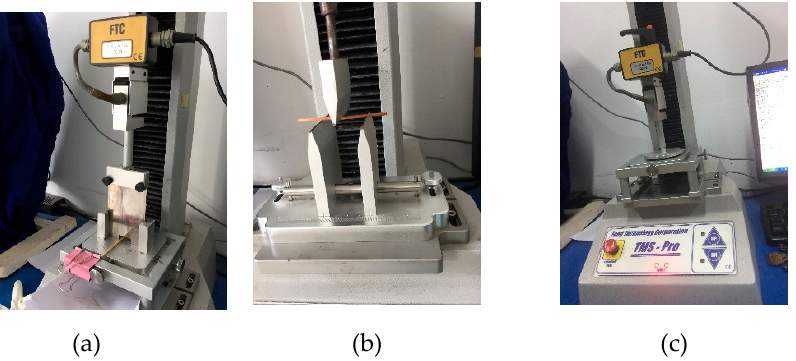
Figure 5. Wheat stalk shearing, bending, and compression. Note: ( a )-shear test, ( b )- bending test, ( c )-compressive test.